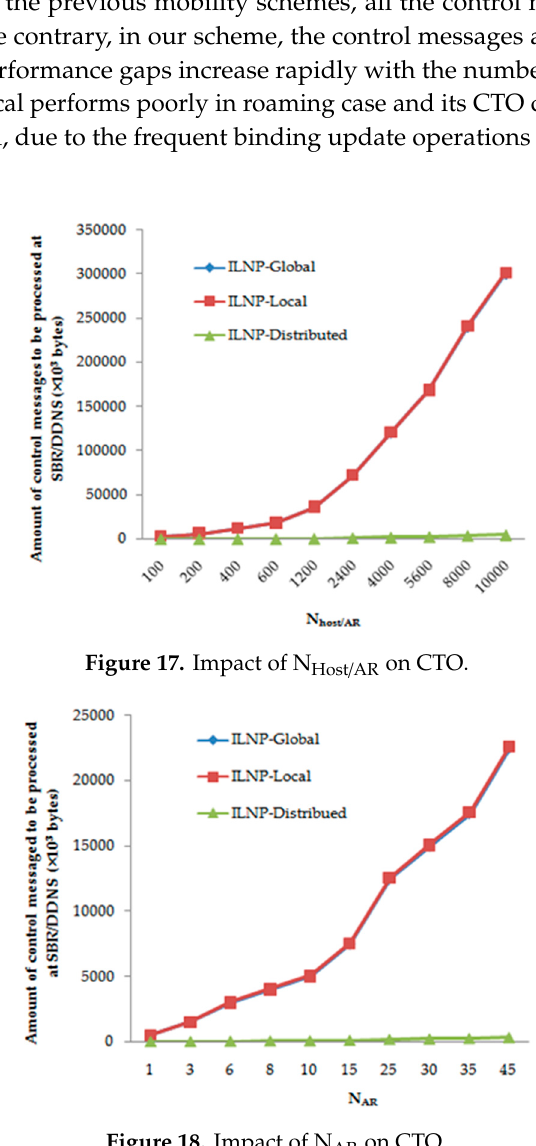
Figure 18. Impact of N AR on CTO.